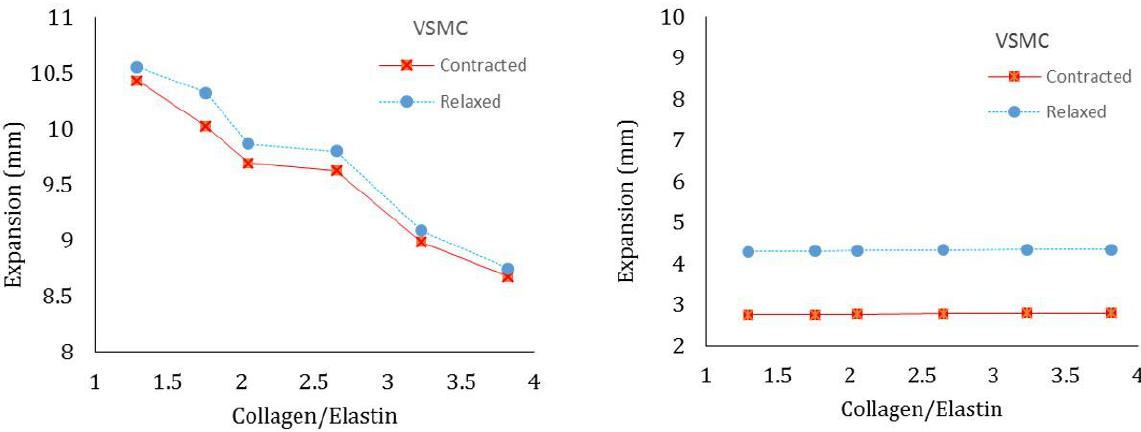
Figure 8: Arterial expansion with respect to the different VSMC status and collagen/elastin ratios; Normal tension (right), hypertension